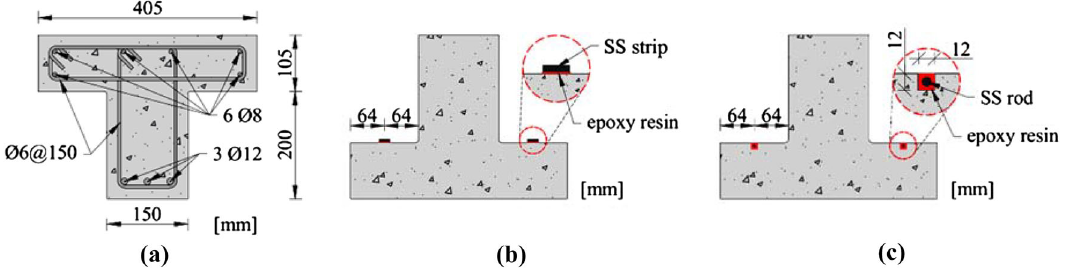
Fig. 2 Scheme of the cross-sectional area of the specimens: a dimensions; b EBR system; and c NSM system.